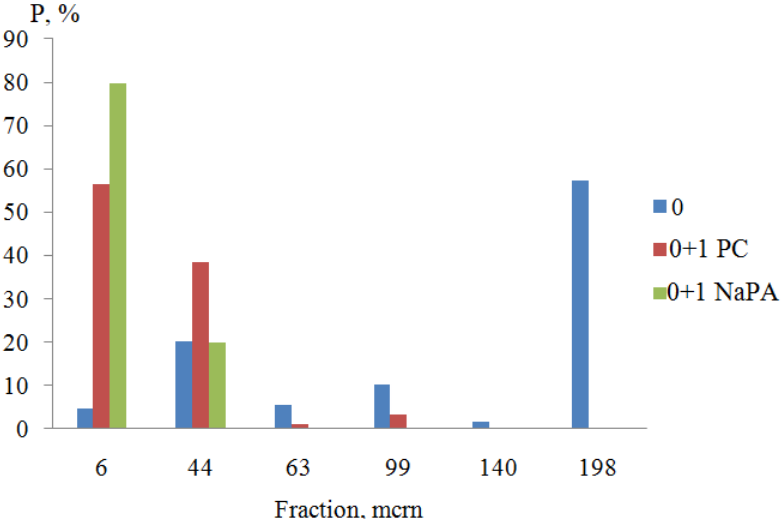
Figure 6. Distribution of titanium dioxide dispersions by size classes in suspensions with a concentration of surfactant CS = 1 g/dm 3.